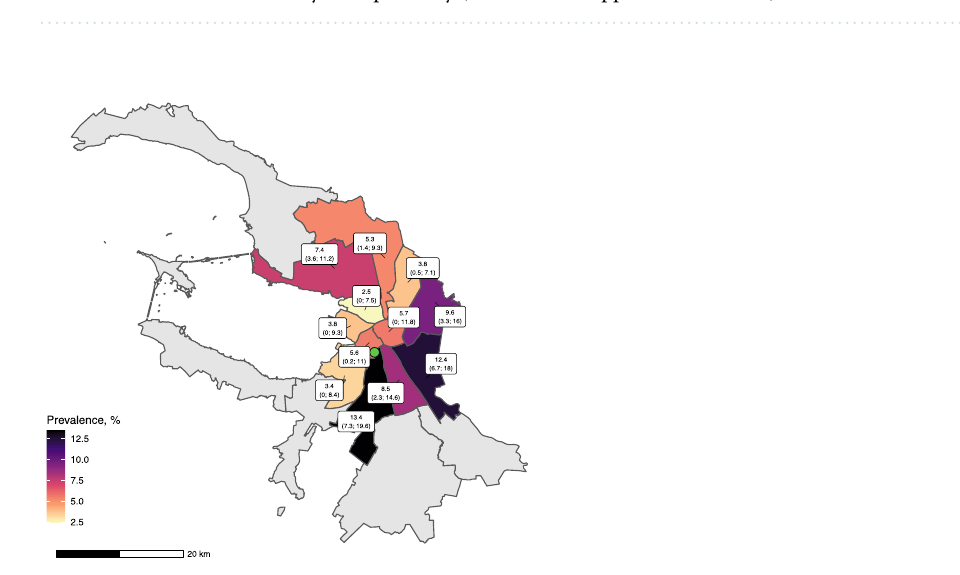
Figure 2. Prevalence estimates by district. This map shows CMIA-based prevalence estimates corrected for participation bias by surveyed districts with 95% CIs in parentheses. Green dot is the clinictest site location. Remote districts excluded from survey are in grey. This map was created with the aid of ggplot2 23 , sf 24 , and ggspatial 25 packages in R 21 using OpenStreetMap data 26